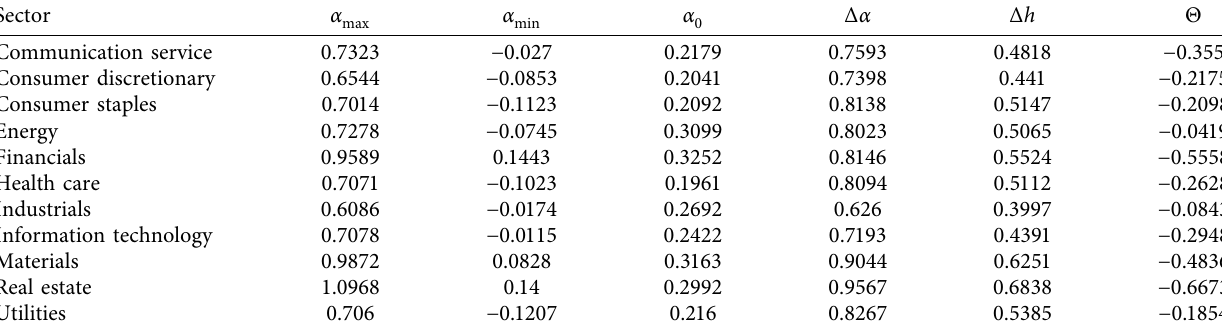
Table 2: The width of the multifractal spectrum Δ α in equation (17) and degree of multifractality Δ h for the MATV for all the sectors. Sector α